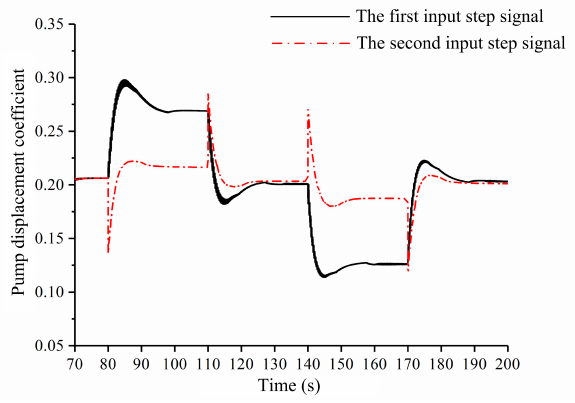
Figure 19. The hydraulic storage pump displacement curve.